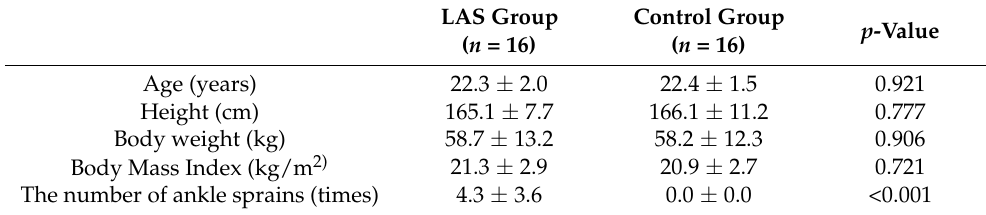
Table 1. Physical characteristics of the